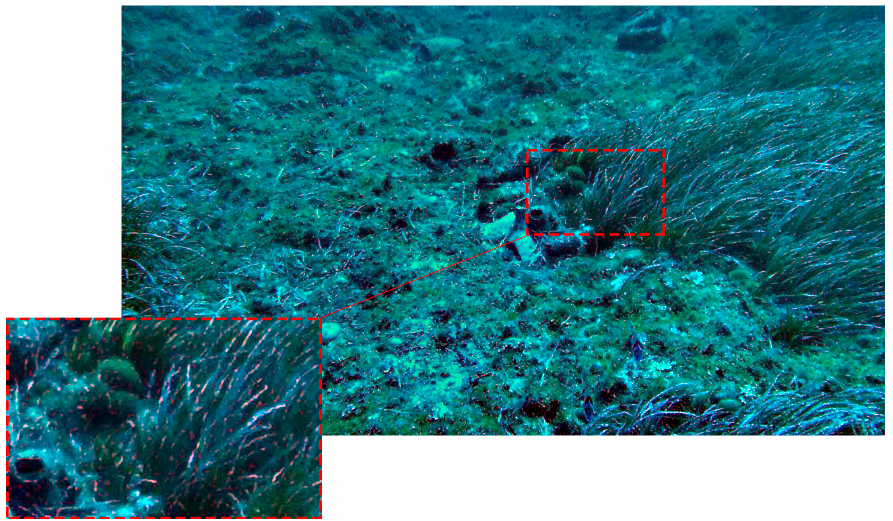
Figure 3. Artefacts in the sample image “CalaMinnola1” enhanced with SP algorithm.